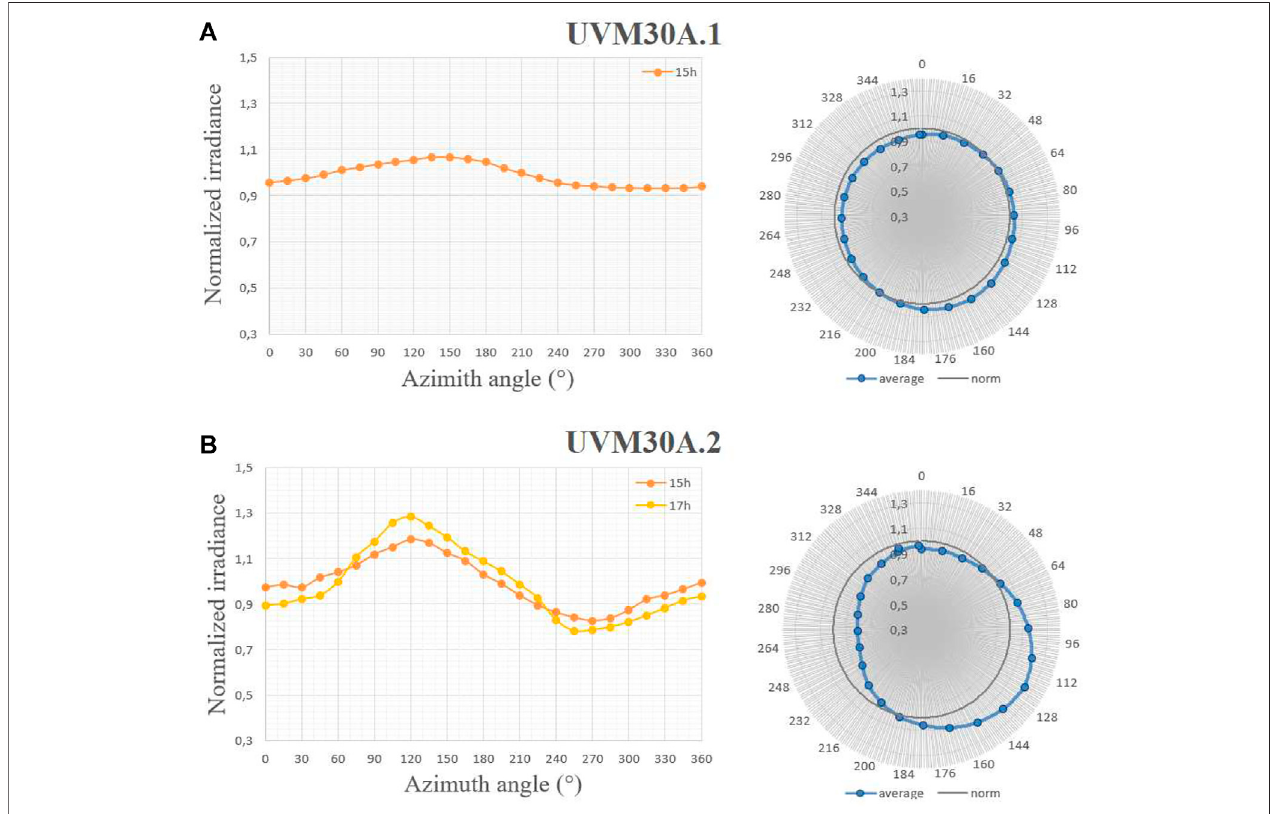
FIGURE 12 | Azimuth response of sensors UVM30A.1 (A) and UVM30A.2 (B) : Output signal for different azimuth angles at different hours (left) and mean azimuth response (right).